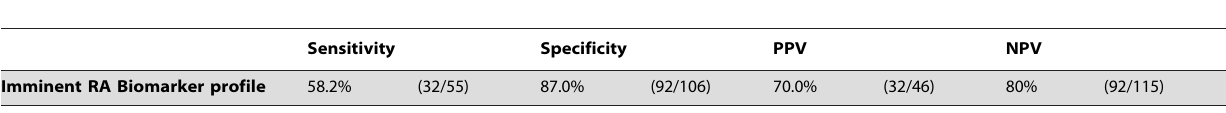
Table 2. Multiplex predictors of imminent RA